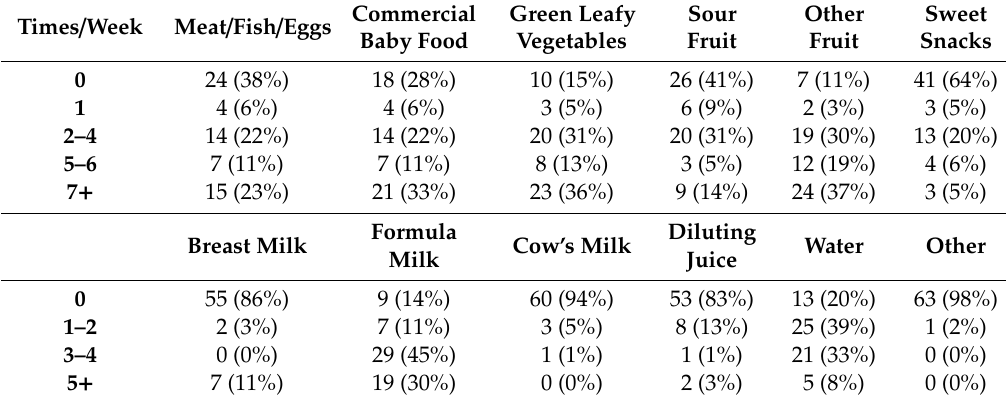
Table 2. Type of foods and drinks given to infants. Food data are frequency (n) and percentage (%) of o ff ered food groups in number of times per week. Drink data are frequency (n) and percentage (%) of o ff ered drinks in number of times per day (n = 64). Times / Week Meat / Fish / Eggs